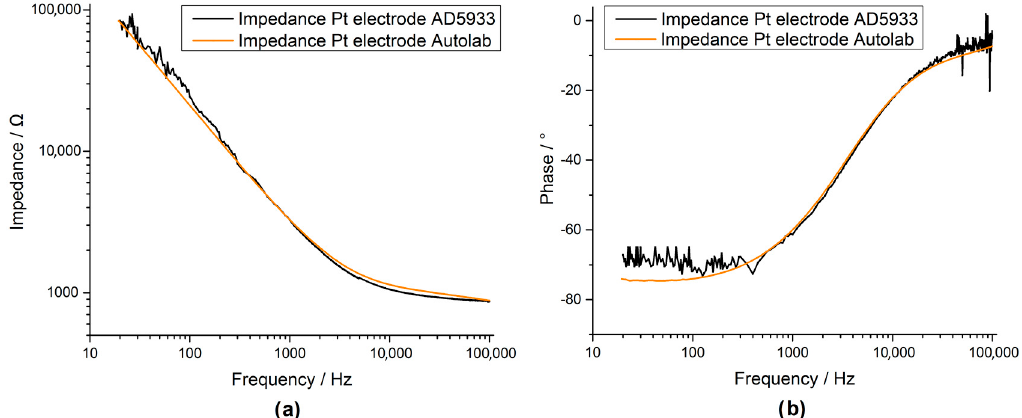
Figure 24. Bode plot of a small platinum electrode with a diameter of 0.85 mm (magnitude ( a ) and phase ( b )). Measurement configured in a three electrode setup. For comparison both the measurement for the custom AD5933 system (black) and the Autolab system (orange) are shown.